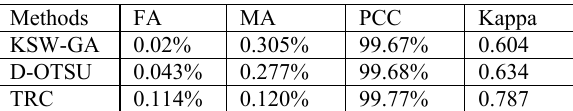
Table 2. Comparison of detection results on